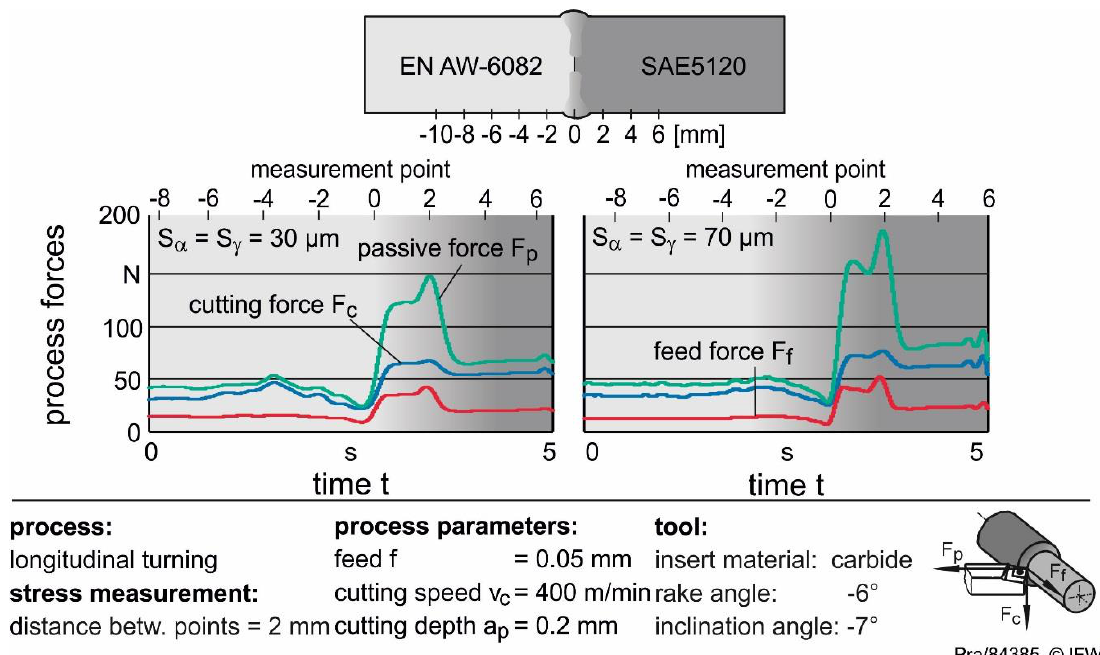
Figure 8. Influence of cutting edge geometry on cutting forces during turning of a steel–aluminium alloy welded shaft.